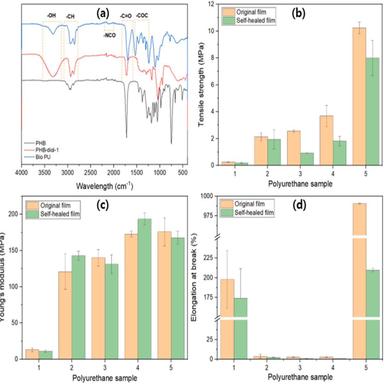
FT-IR spectra of original PHB, PHB-diol, and bio PU produced from PHB-diol (a); Tensile strength (b), Young's modulus (c), and elongation at break (d) of original and healed PU films. Mechanical characterization results are presented as the mean values of two independent replicates. The error bars represent the standard deviations of the mean values.